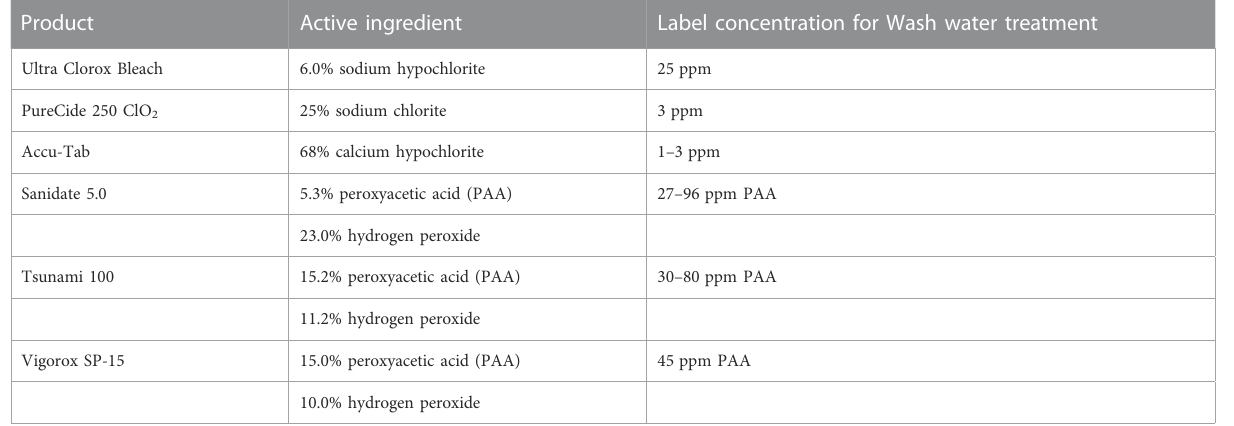
TABLE 2 Summary of sanitizing chemicals commonly used on many farms showing the differences in